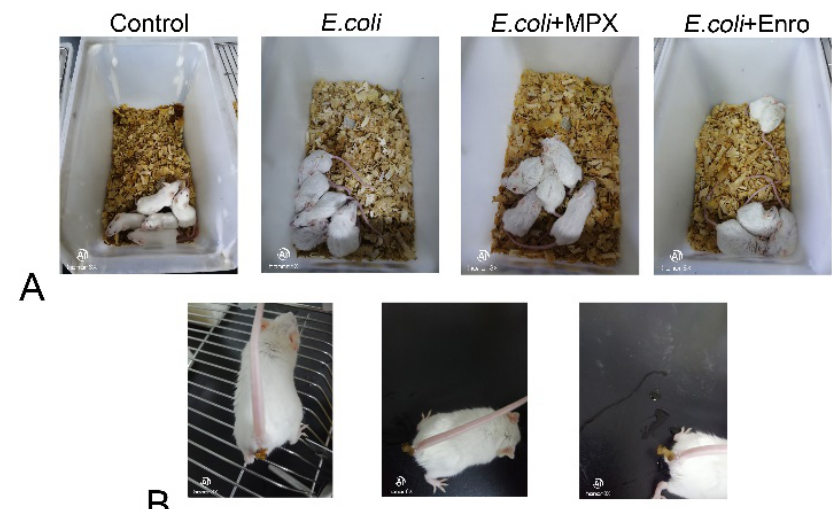
Fig. 1 . Observation of clinical symptoms of E. coli infection with BALB/c mice (A,